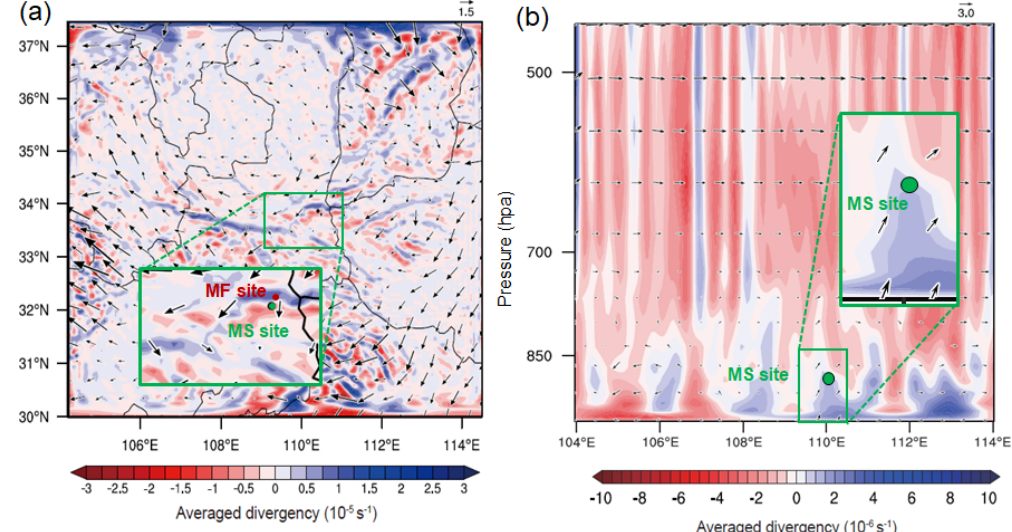
Figure 5. The distribution of averaged diurnal divergence over the whole campaign, with the corresponding wind field. (a) Horizontal distri- bution at surface. (b) Longitude–pressure cross-sections at 34 ◦ 29 (cid:48) N. Wind speeds were represented by arrows sizes, and the W component of wind vectors was magnified 10